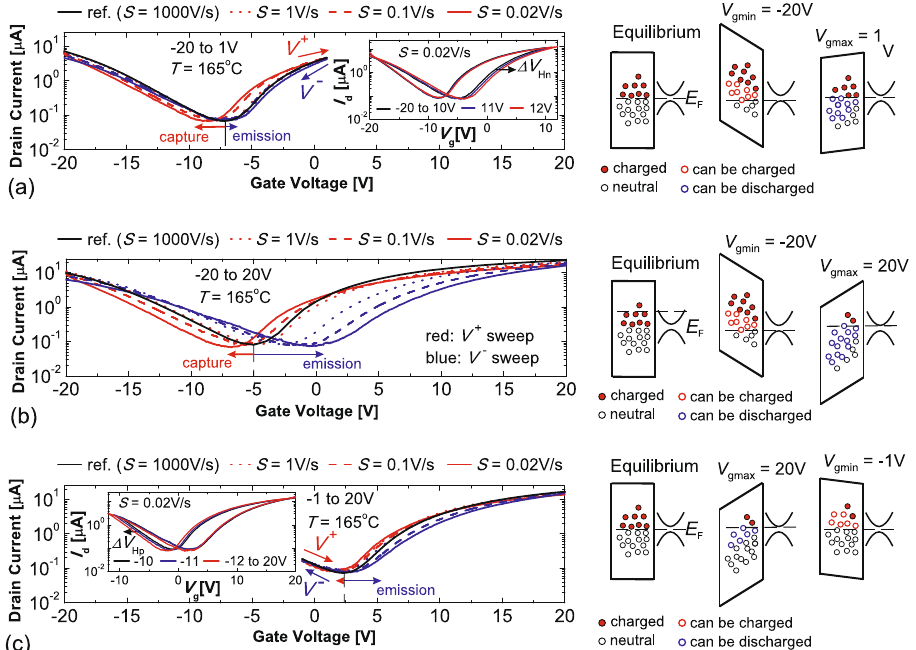
Fig. 2 The I d − V g characteristics measured using different sweep ranges. a − 20 to 1 V. For slow sweeps, many defects can capture a hole (i.e., become charged) within the hole conduction region. This makes V þ more negative than it was for the reference curve ( S = 1000 V/s). At the NP same time, a small V gmax limits hole emission in the electron conduction region, which leads to a small hysteresis. Furthermore, an increase of V gmax makes hole emission more effecient and leads to a more positive V (cid:2) and larger Δ V Hn (inset). b − 20 to 20 V. The total hysteresis width is NP mainly due to hole emission. c − 1 to 20 V. The contribution of hole capture is negligible due to the small absolute V gmin . The hysteresis width Δ V Hp is sensitive to V gmin ( inset